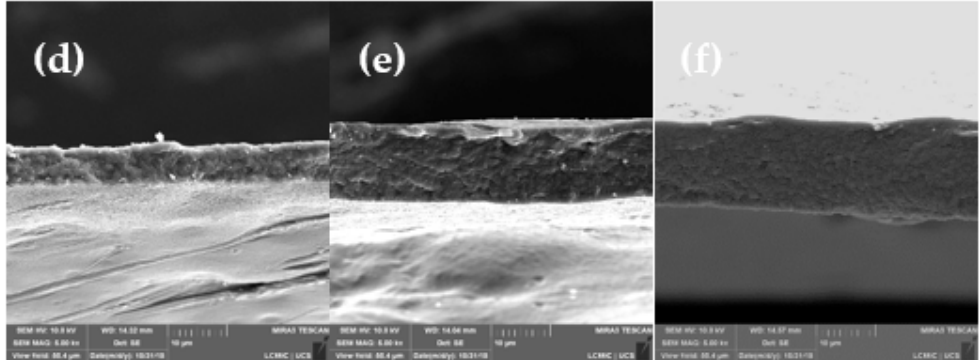
Figure2. SEM imagesof the surface (250 × ) and cross-section (5000 × ) hemicellulosefilms: ( a , d ) 2 %(w / v), Figure 2. SEM images of the surface (250×) and cross-section (5000×) hemicellulose films: ( a , d ) 2 ( b , e ) 3 % (w / v), ( c , f ) 4 % (w / v). %(w/v), ( b , e ) 3 % (w/v), ( c , f ) 4 % (w/v).